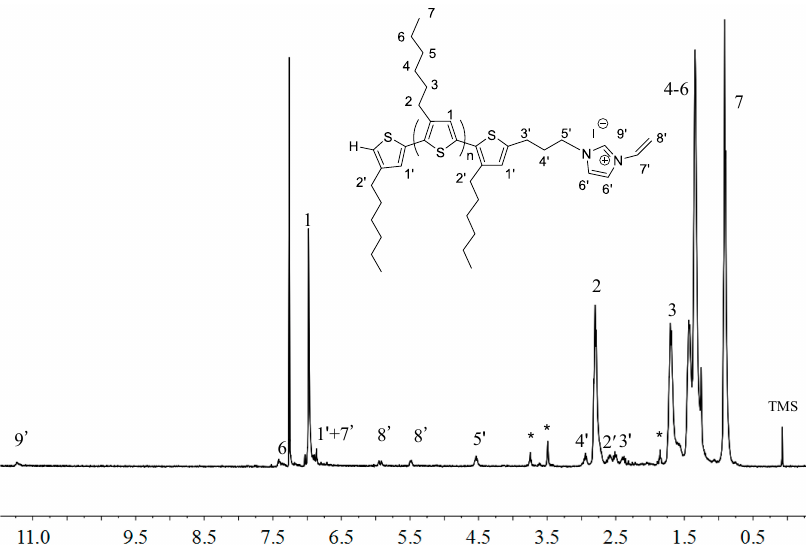
Figure 5. 1 H-NMR (400 MHz, CDCl 3 ) spectrum of P3HT-(CH 2 ) 3 -VIM with MW~2000 g/mol. Peaks marked * correspond to residual solvent signals.